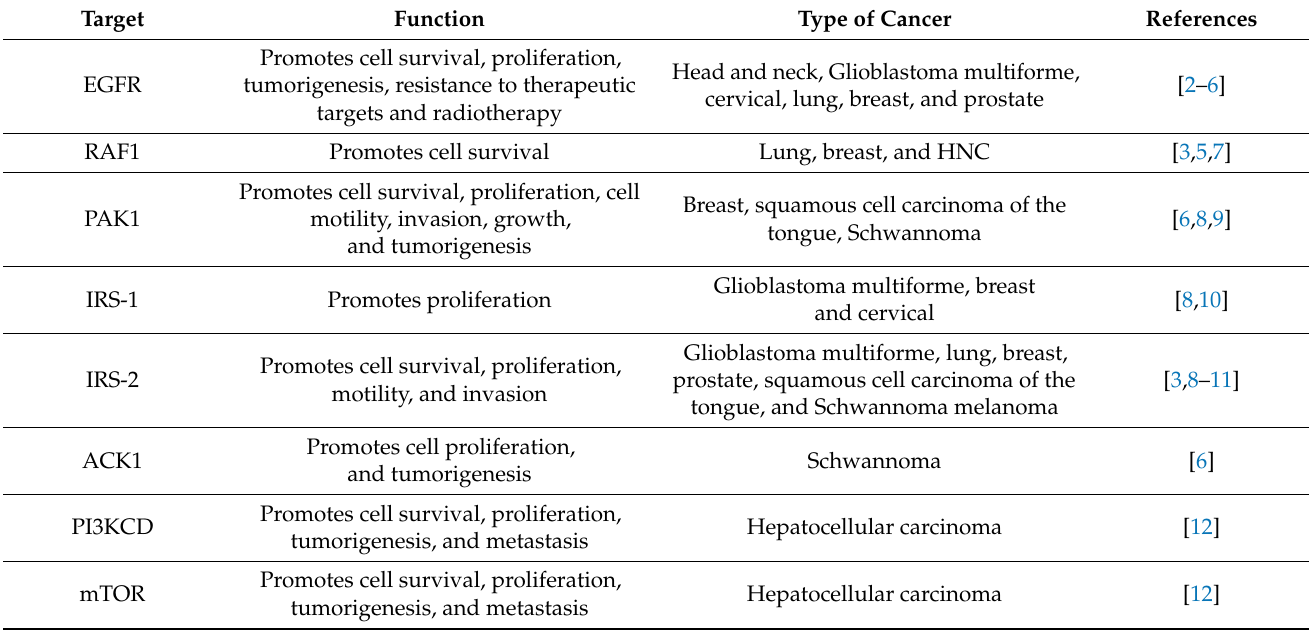
Table 1. miR-7 targets and functions of target genes in cancer. Taken and modified from “microRNA-7: A tumor suppressor miRNA with therapeutic potential” [48].